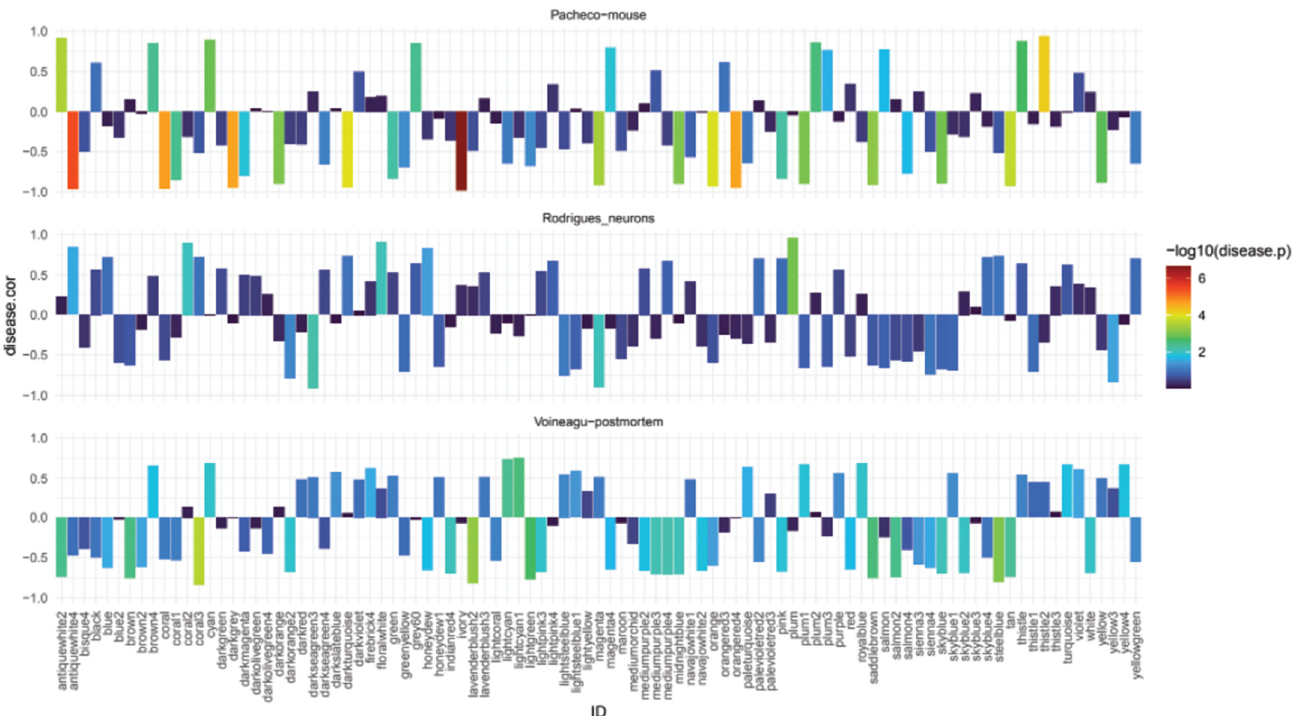
Figure 4. Module-feature associations. Each row corresponds to a module eigengene and its correla- tion with the clinical phenotype (disease status). Correlation coefficient is represented in log10 scale, where blue corresponds to a negative one correlation coefficient, and red corresponds to positive one correlation coefficient.